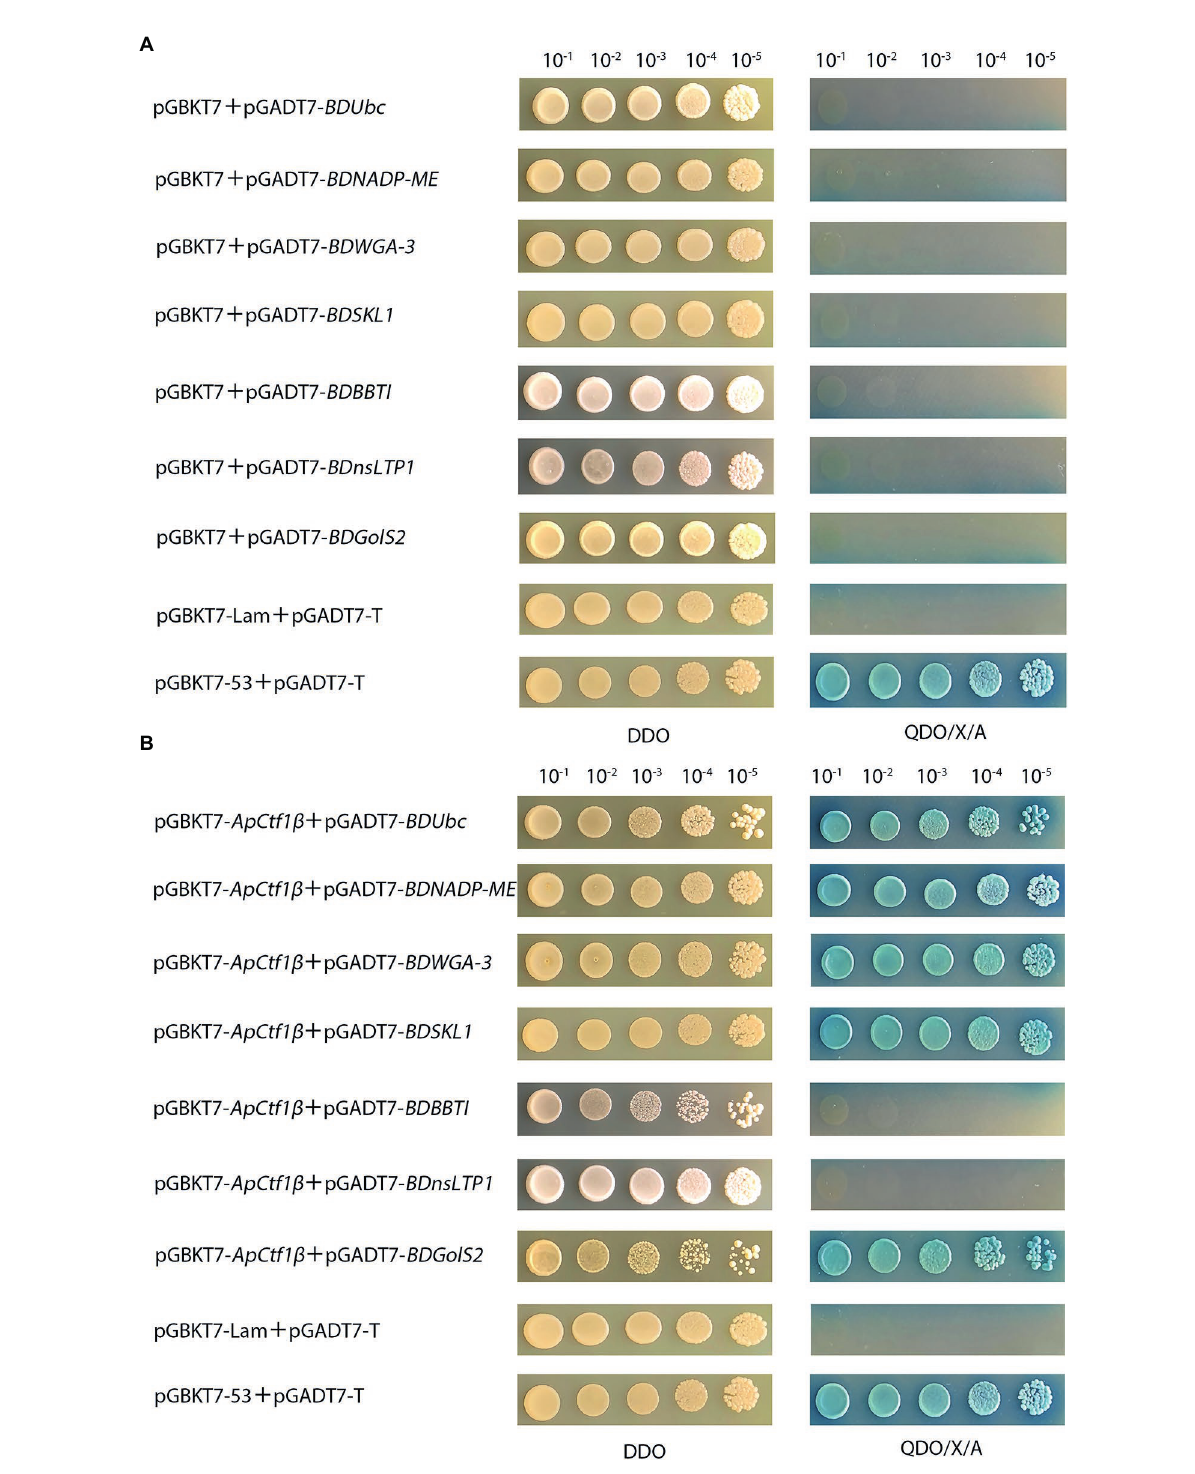
FIGURE 2 (A) Self-activation validation of positive candidate gene from gradient dilution spot medium; pGBKT7 + pGADT7- BDUbc , pGBKT7 + pGADT7- BDNADP-ME , pGBKT7 + pGADT7- BDWGA-3 ,pGBKT7 + pGADT7- BDSKL1 ,pGBKT7 + pGADT7- BDBBTI , pGBKT7 + pGADT7- BDnsLTP1 , and pGBKT7 + pGADT7- BDGolS2 were the experimental groups; pGBKT7-53 + pGADT7-T was the positive control; pGBKT7-Lam + pGADT7-T was the negeative control; (B) Validation of positive candidate gene from gradient dilution spot medium. pGBKT7- ApCtf1 β + pGADT7- BDUbc , pGBKT7- ApCtf1 β + pGADT7- BDNADP-ME , pGBKT7- ApCtf1 β + pGADT7- BDWGA-3 , pGBKT7- ApCtf1 β + pGADT7- BDSKL1 , pGBKT7- ApCtf1 β + pGADT7- BDBBTI , pGBKT7- ApCtf1 β + pGADT7- BDnsLTP1 , and pGBKT7- ApCtf1 β + pGADT7- BDGolS2 were the experimental groups; pGBKT7-53 + pGADT7-T was the positive control; pGBKT7-Lam + pGADT7-T was the negeative